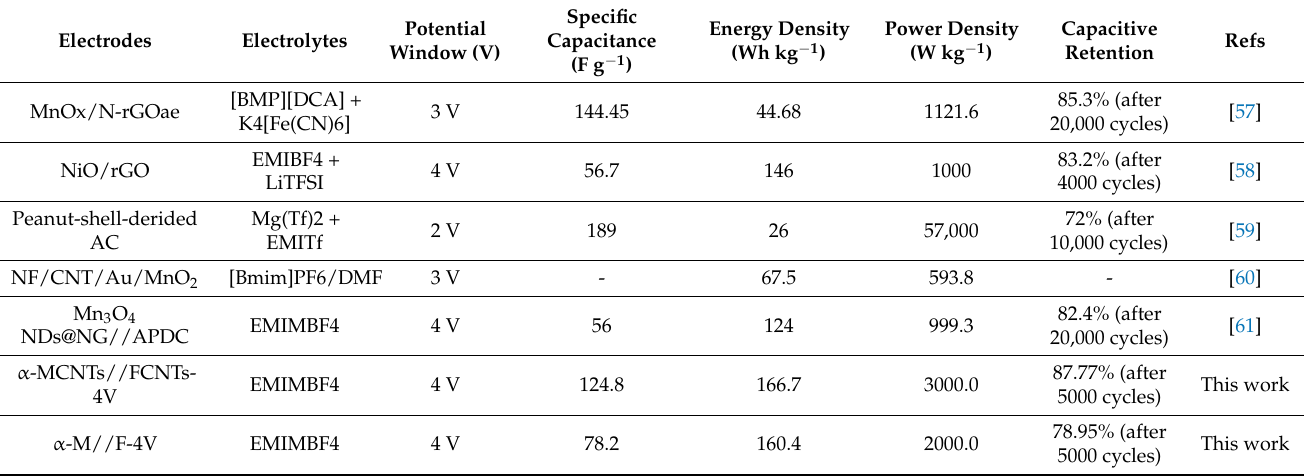
Table 1. Comparison of the specific capacitances, energy densities, power densities, and capacitive retention of ionic liquid electrolyte-based